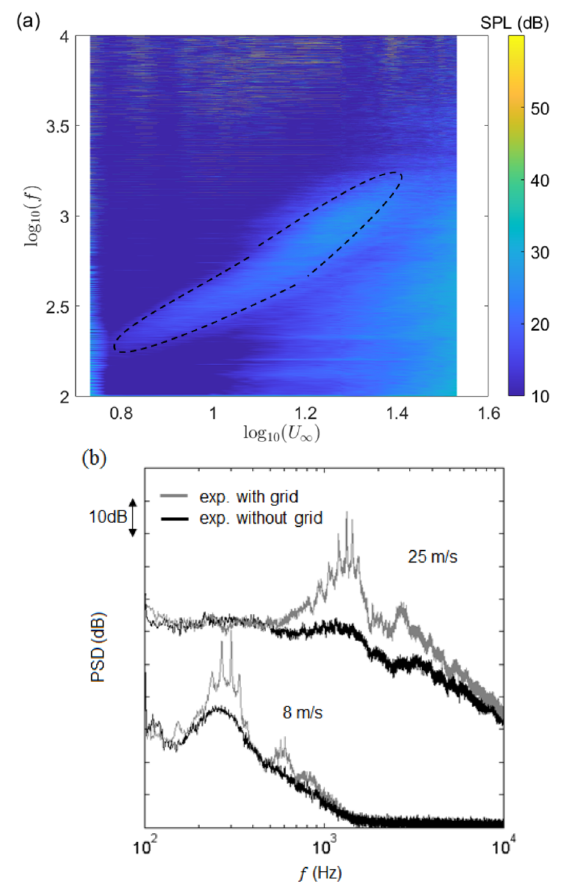
Figure 10. ( a ) Frequency-flow speed chart for NACA-0012 airfoil at zero AOA with small-scale turbulence; ( b ) compared far-field sound spectra of the clean flow (grey) and with upstream turbulence (black). Flow speeds 8 m/s and 25 m/s. Both pairs of spectra are shifted by 20 dB from each other. [15].